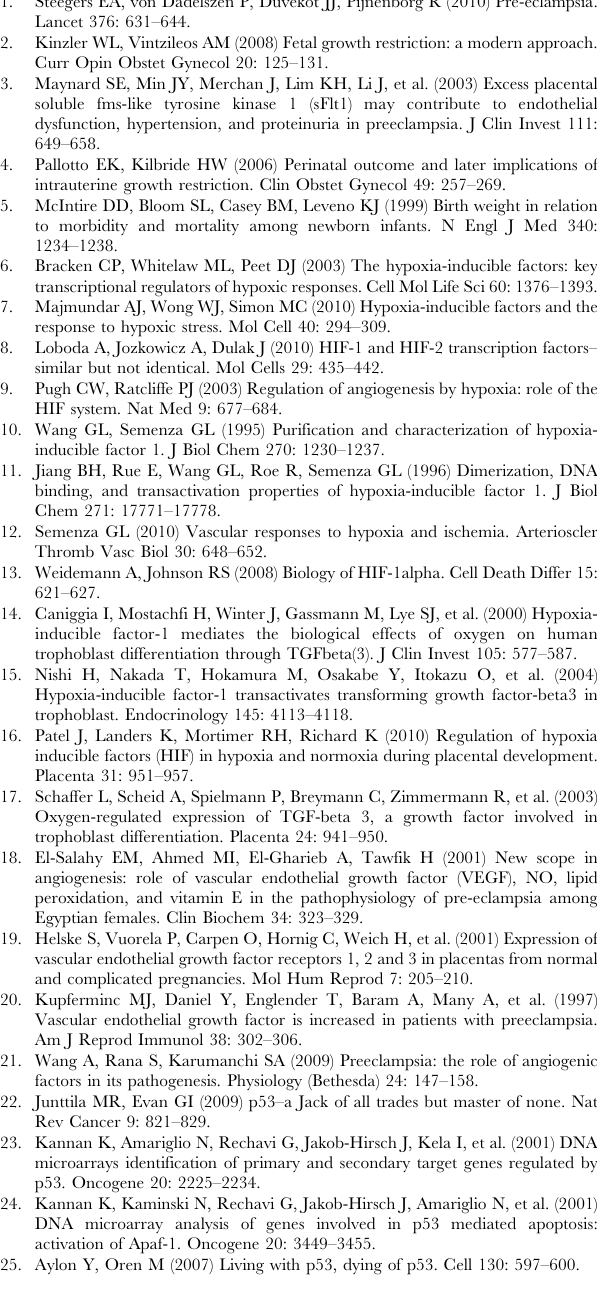
Table S2 Selected genes induced by (A) hypoxia and (B) p53. Table S3 Delta Ct and Delta-Delta Ct calculations for the study cohort. Table S4 Analysis of the study population: Significant results (p , 0.05) are highlighted by a grey background.